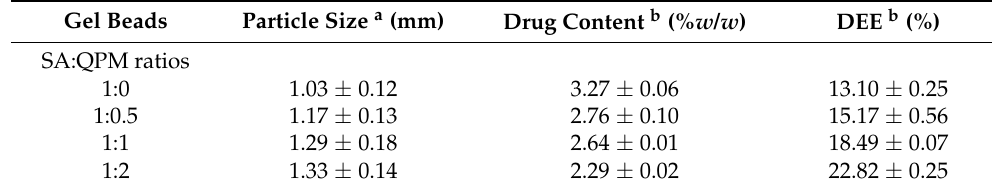
Table 2. Particle size and drug entrapment efficiency of PPN-loaded CA-QPM gel beads.